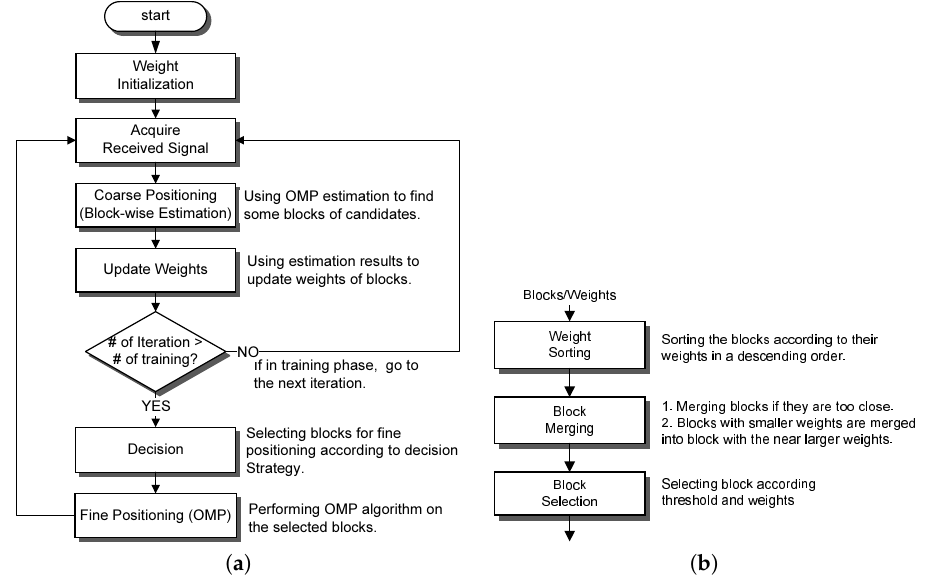
Figure 4. ( a ) Flow chart of the proposed low-complexity two-stage OMP reconstruction algorithm and ( b ) the decision